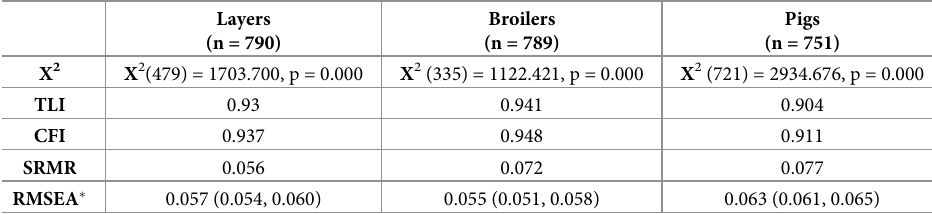
Table 9. Goodness of fit statistics for the structural equation modelling for each animal